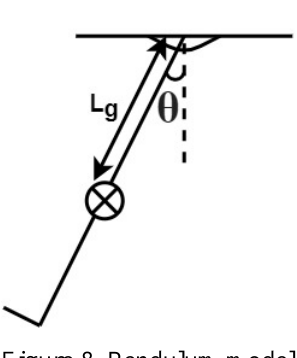
Figure 8. Pendulum model